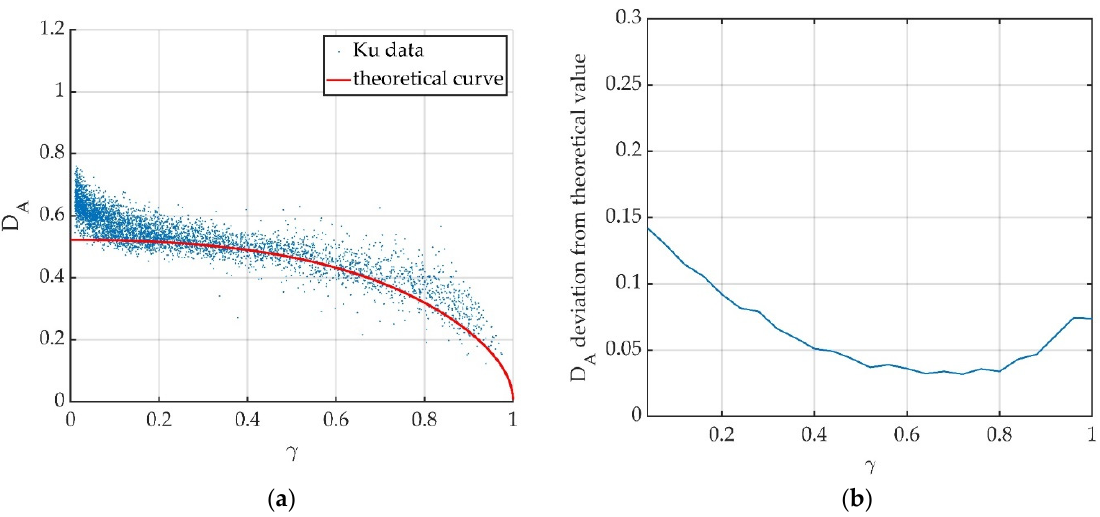
Figure 9. Results obtained for Ku-band data. ( a ) Relation between amplitude dispersion index D A and coherence γ of experimental data compared to the theoretical red curve, Equation (14). Each dot represents a resolution cell in the analyzed area. ( b ) Deviation of experimental D A values from theoretical ones.